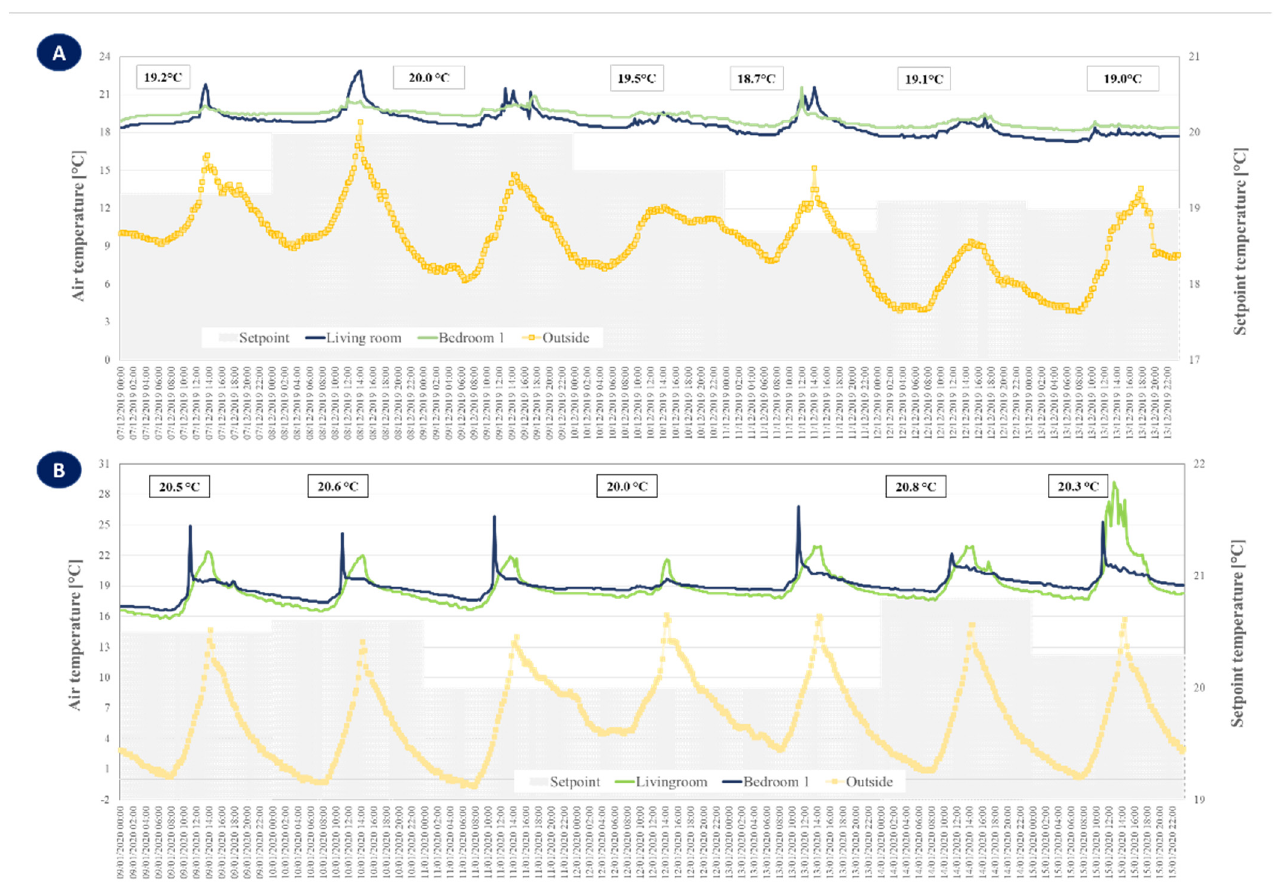
Figure 3. Air temperature trend: ( A ) setpoint lower that 20 °C and ( B ) upper 20 °C.